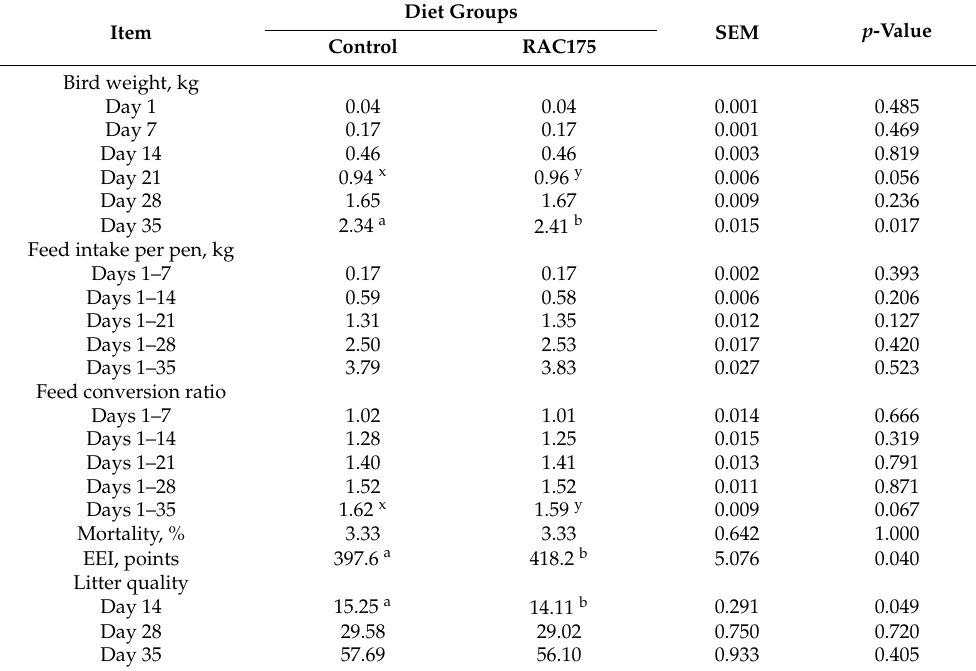
Table 6. Results of Trial 2.